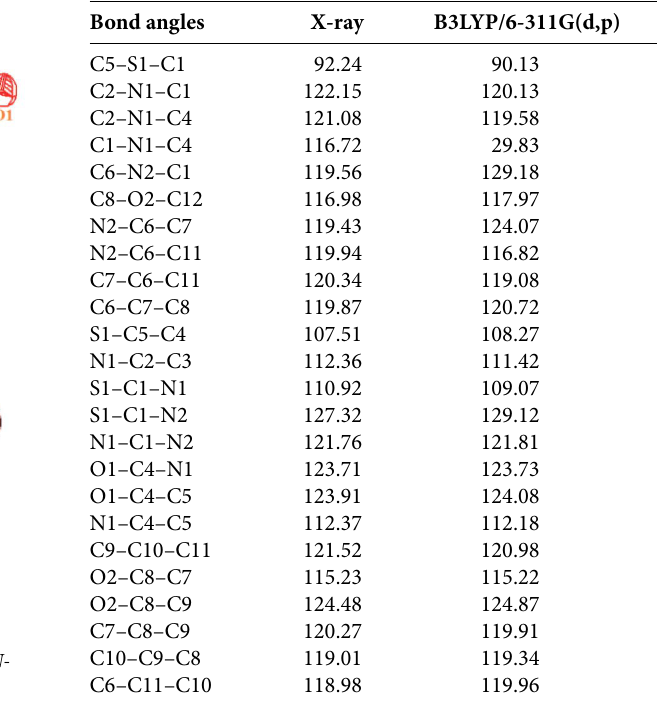
Table 3. Experimental and optimized bond angles (°).